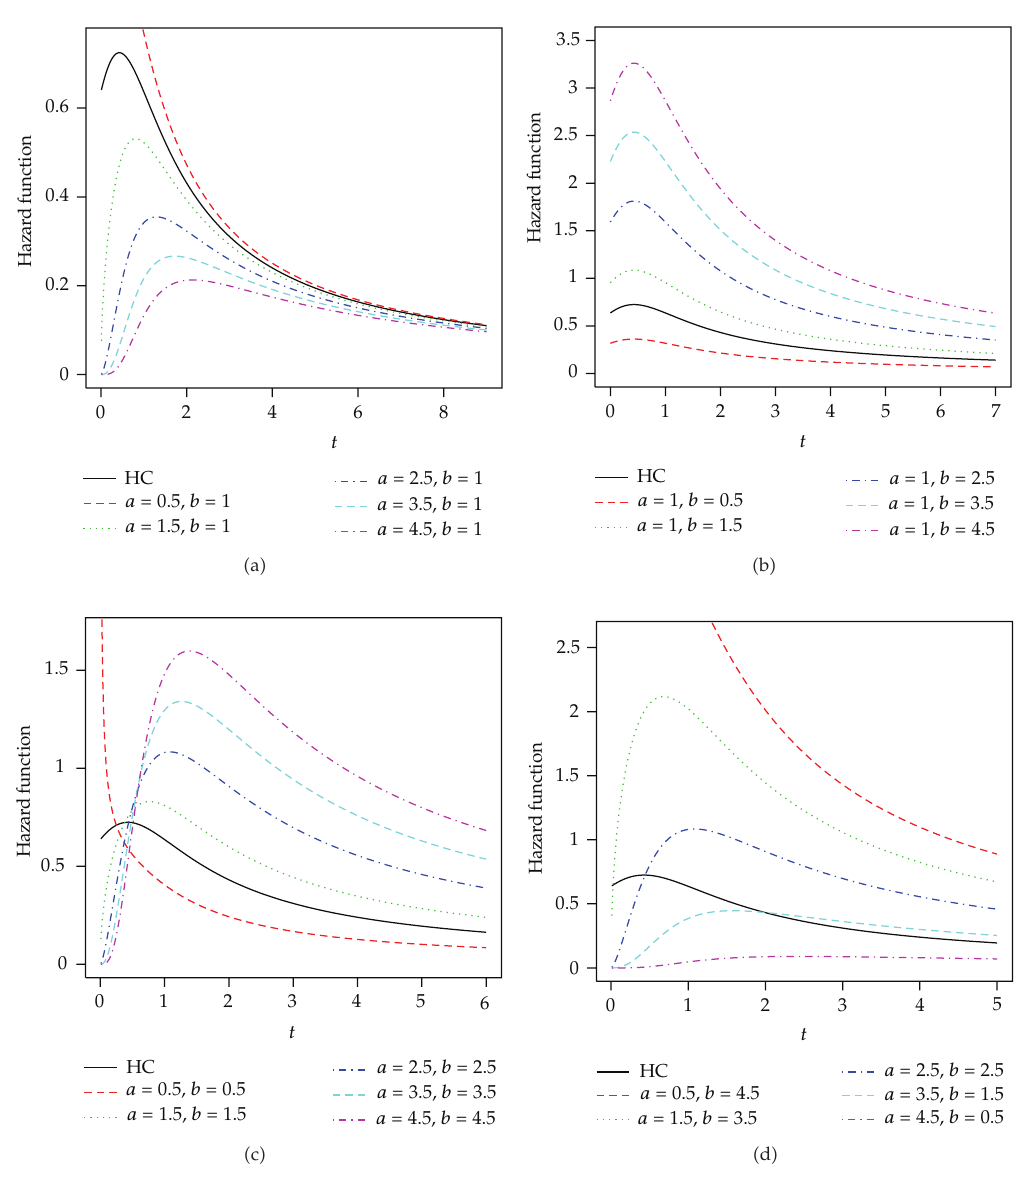
Figure 2: Plots of the hazard rate function (cid:2) 2.5 (cid:5) for some parameter values; φ (cid:6)